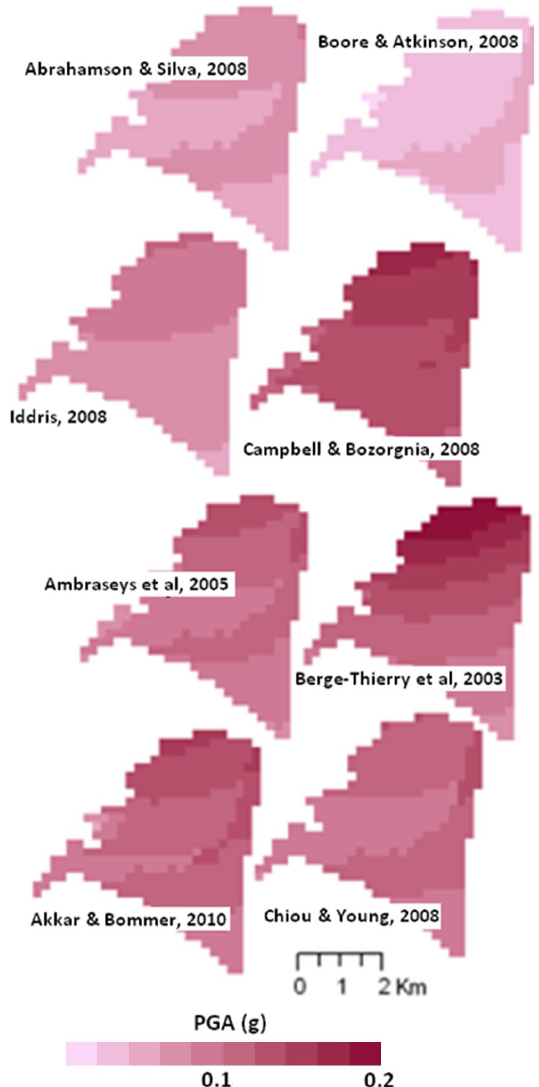
Fig. 3. Expected acceleration in Almería according to different at- tenuation models.